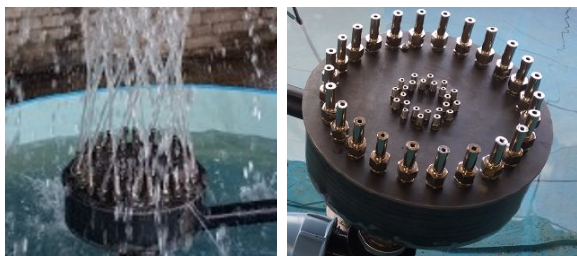
Fig. 13 . Simulation